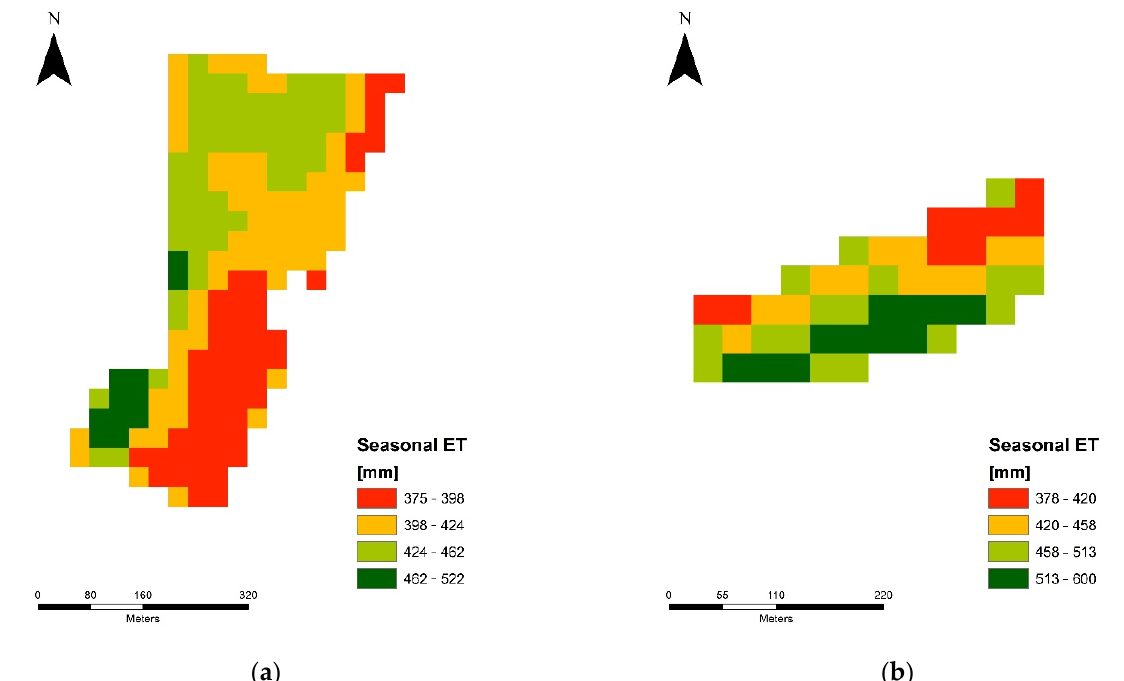
Figure 4. SEBAL seasonal ET maps generated for Field 1 ( a ) and Field 5 ( b ). The fraction ETrF j ranged from a minimum average of 0.64 in field 4 to a maximum of 1.15 in field 5. Moderate variability was observed for all the investigated fields, with a coefficient of variation ranging between 3.6% (field 2) and 10.1% (field 3). SEBAL-based algorithm well predicted the biomass at the two undamaged fields (field 6 and 7. SEBAL biomass was not calculated for field 8), with an average error of − 4.0%, but underestimated (on average, − 19.3%) biomass in most of the damaged fields with differences up to 35.0% as the maximum observed at Field 4. Considering all the damaged and undamaged fields, SEBAL underestimated the actual biomass by 15.1% (Figure 5).